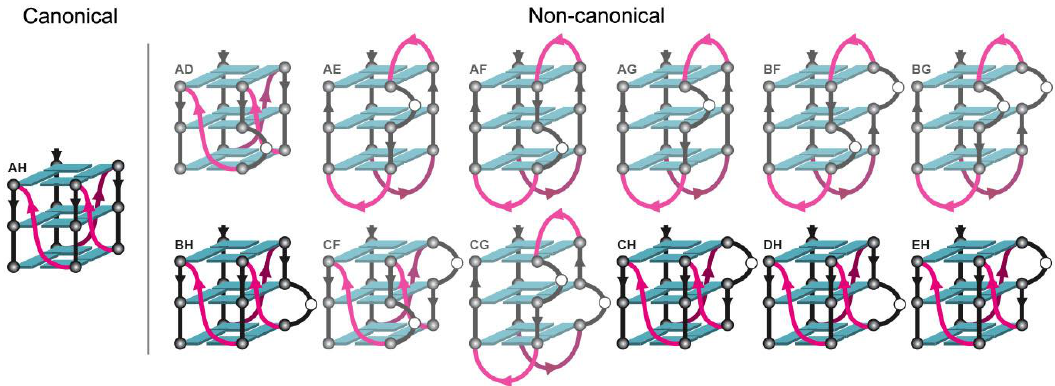
Figure 11. Possible topologies that can be adopted by the trim_A5U oligonucleotides. Out of 13 conformation possibilities predicted by the extended model, only one is canonical (A5U A ), while 12 others contain a bulge in G-tract II, III, or in both G-tracts. ZmNDPK1 binds to the variants with the conserved GGGAGGG hairpin (contrasted models).